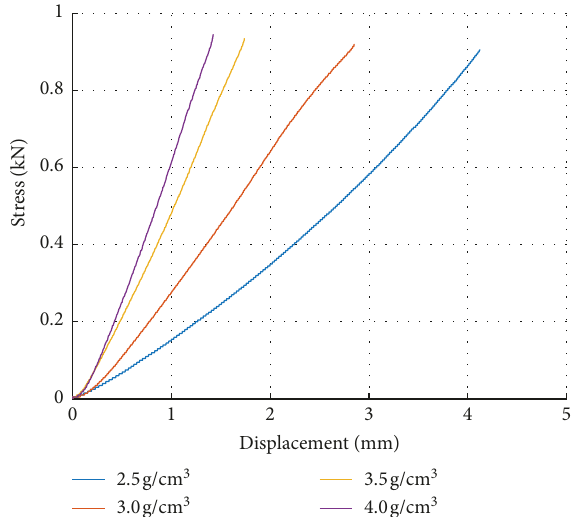
Figure 6: Force loading tests of MR with different densities.